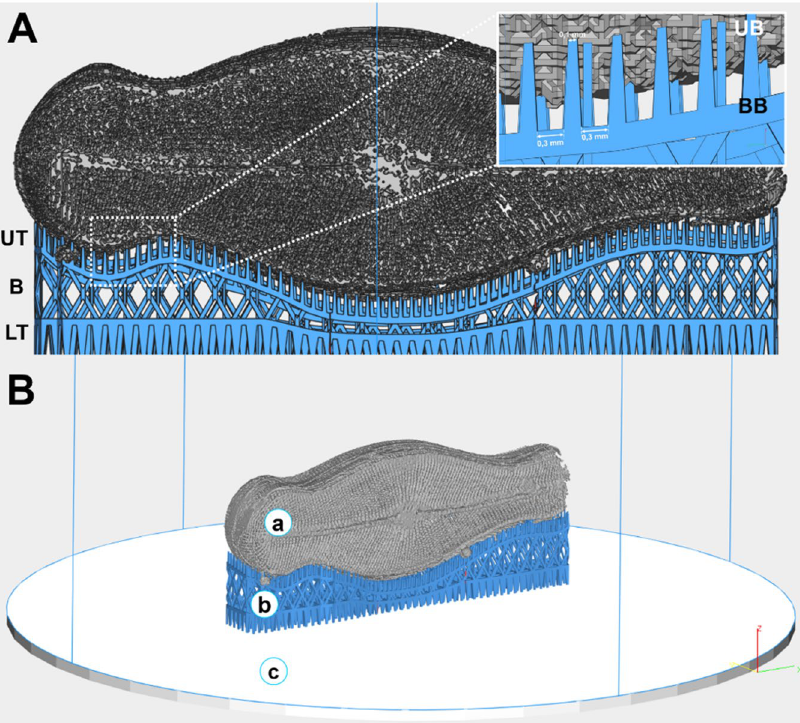
Figure 8. ( A ) Connection between the 3D printed engineered object and the support structure. UT – upper teeth, B – body, LT – lower teeth. Inset: magnification of the connection: UB – upper base, BB – bottom base. ( B ) Visualization of the 3D printed engineered object (a), support structure (b) and building platform